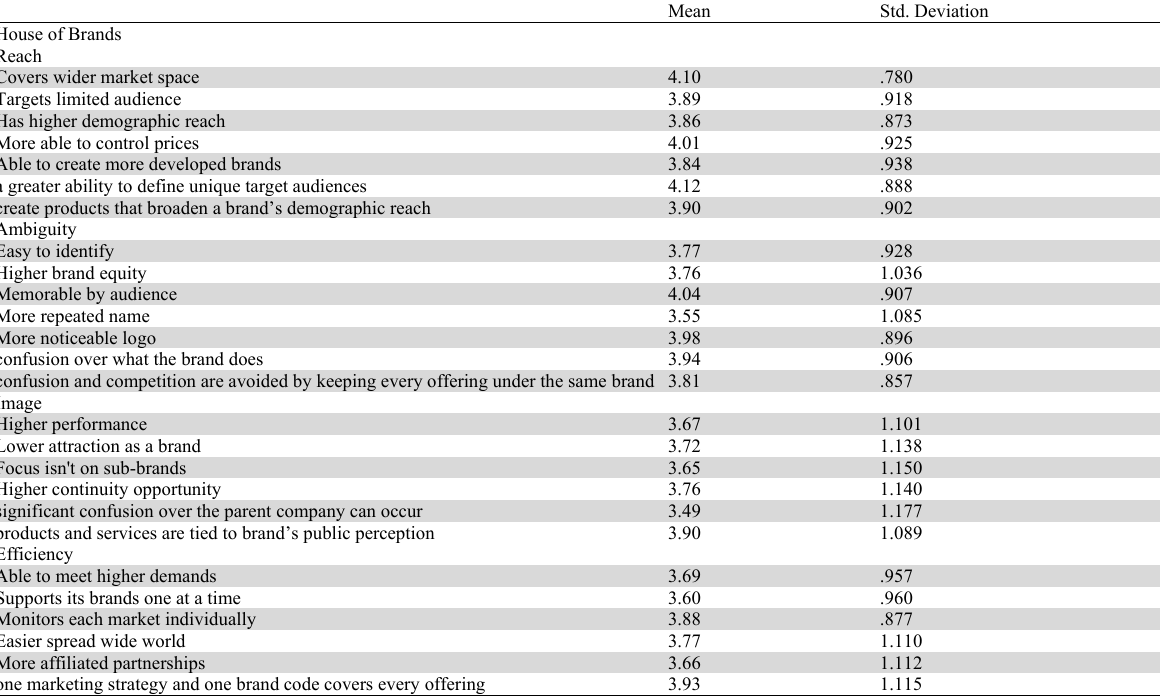
House of Brands House of Brands Reach Covers wider market